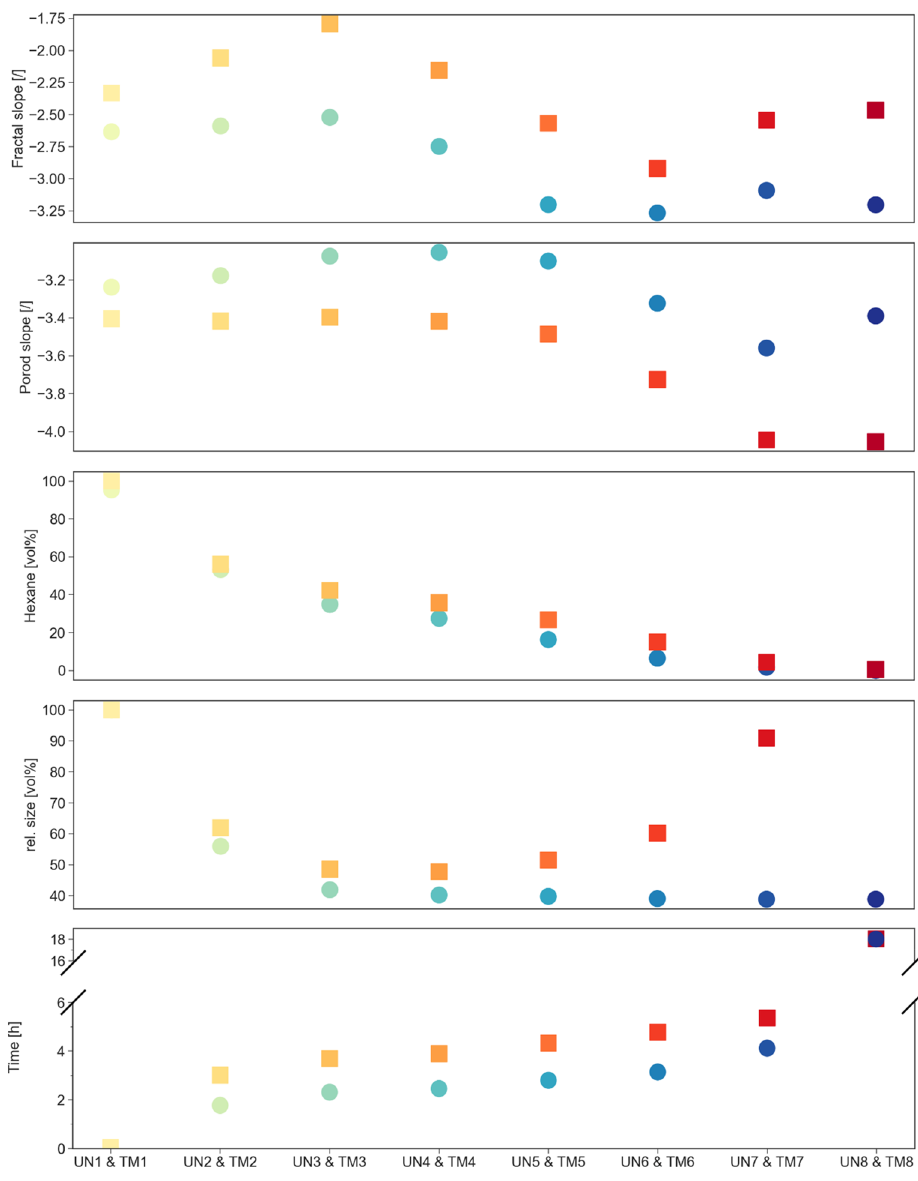
Figure 5. Overview of distinct features of the in-situ X-ray scattering experiment are visualized for specific points of interest UN1-UN8 (green/blue) and TM1-TM8 (yellow/red) as a function of fractal slope, Porod slope, hexane, relative size, and time, respectively. The relative size was estimated by measuring the area in the photographs. The last value (TM8) for the TM sample could not be measured due to the cracking induced by the sample falling